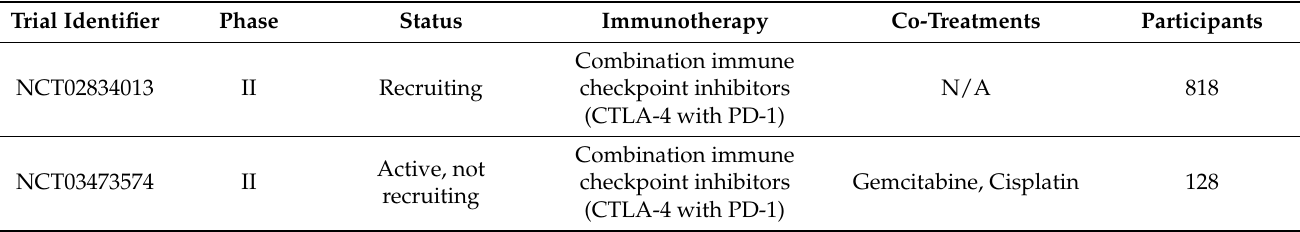
Table 2. Clinical trials currently evaluating immunotherapies in CCA. List of clinical trials involving combination immune checkpoint inhibitors, adoptive cell transfer, and other innovative immunotherapies in CCA. Source: clinicaltrials.gov (28 July 2021). CCA, cholangiocarcinoma; TIL, tumor-infiltrating lymphocyte; CAR-T cell, chimeric antigen receptor T cell; CIK, cytokine-induced